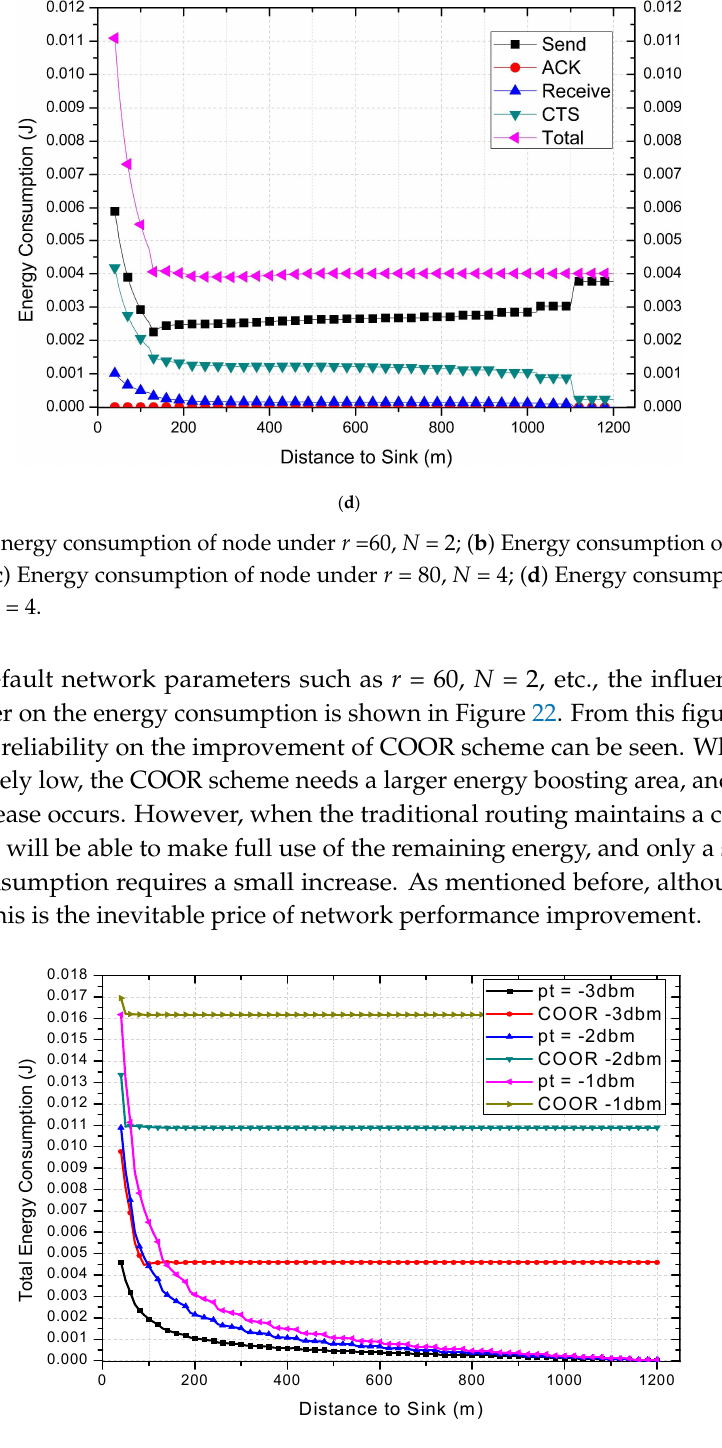
Figure 21. ( a ) Energy consumption of node under r =60, N = 2; ( b ) Energy consumption of node under r = 70, N = 3; ( c ) Energy consumption of node under r = 80, N = 4; ( d ) Energy consumption of node under r = 90, N = 4.